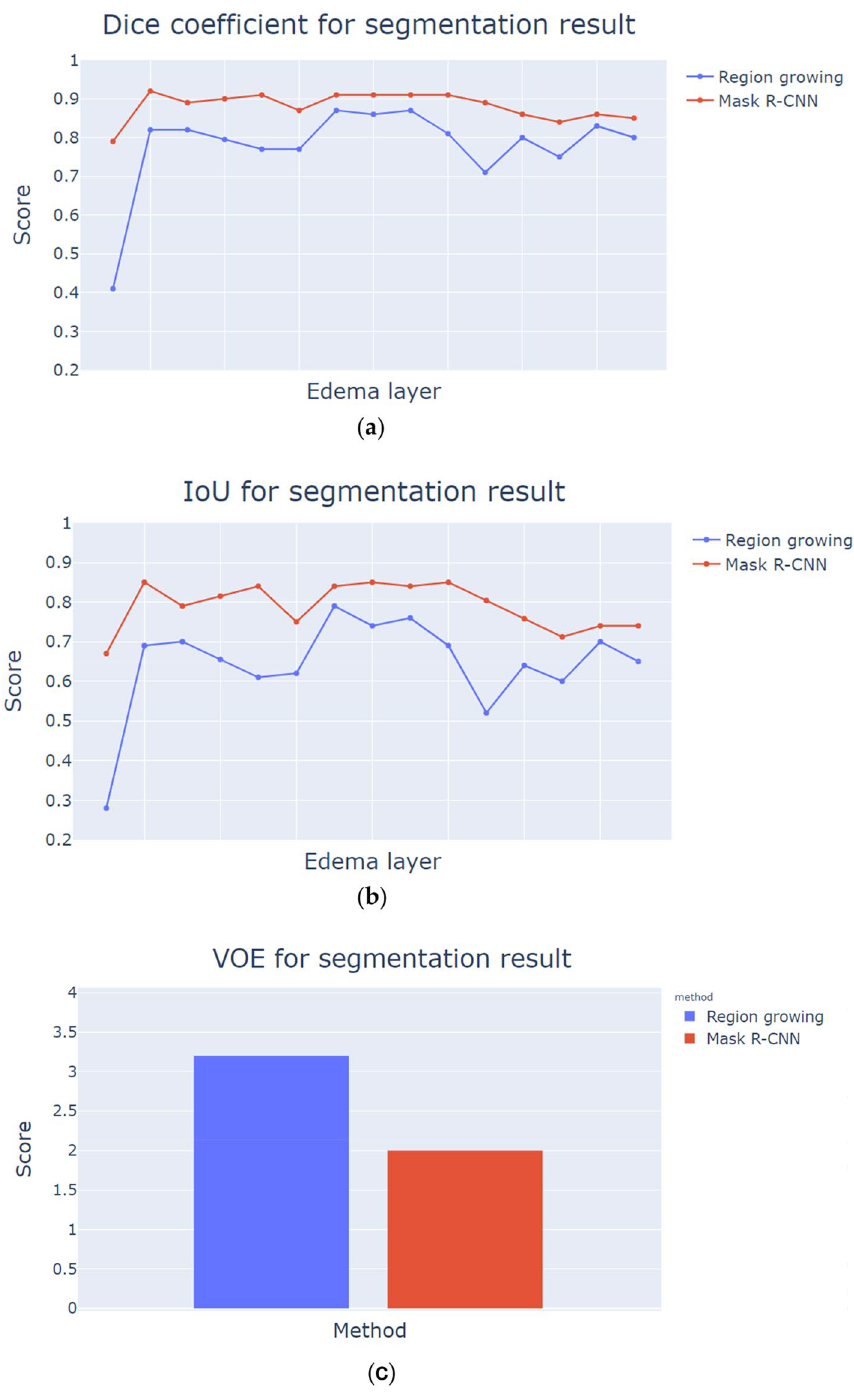
Figure 7. Evaluation index for segmentation results. ( a ) DICE index, ( b ) IoU index, ( c ) VOE index. R-CNN region-based convolutional neural networks, IoU intersection over union, VOE volumetric overlap error.